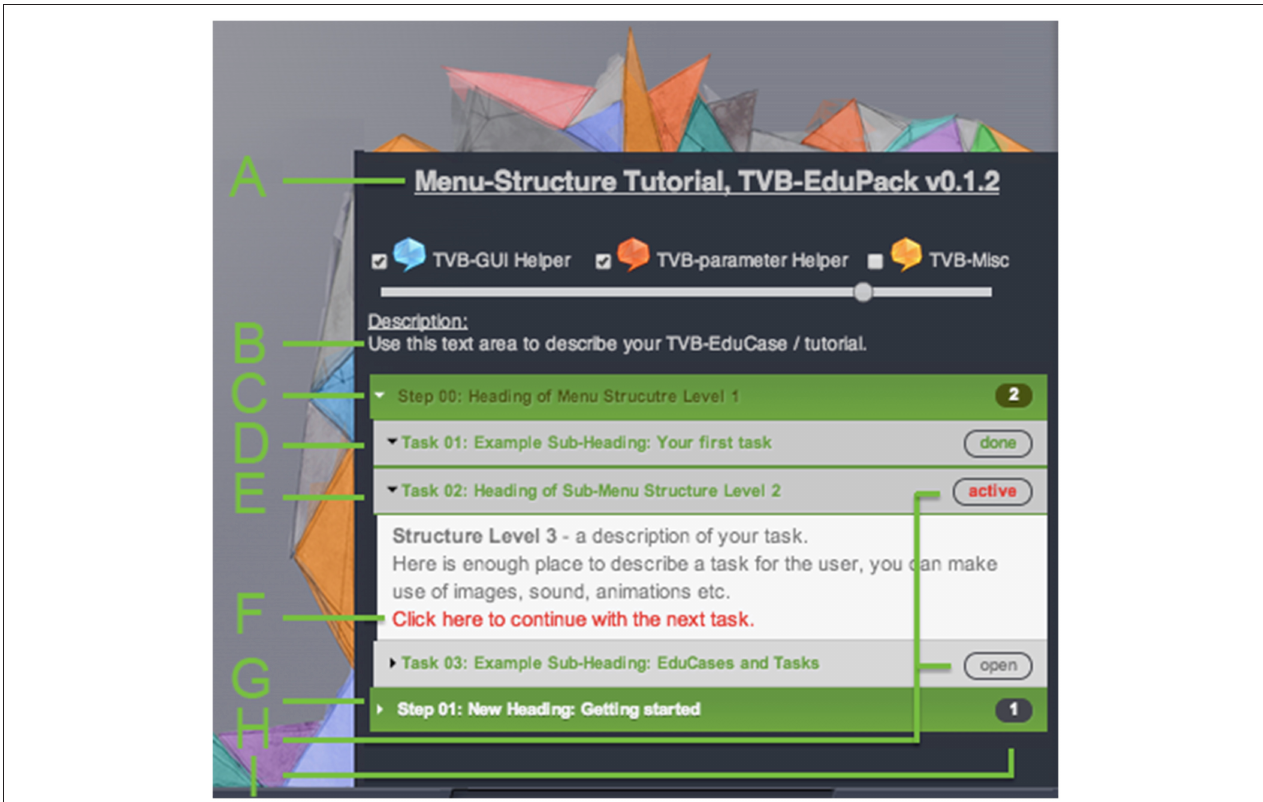
FIGURE 3 | Lower right section of the TVB Connectivity interface with activated TVB-EduPack in Tutorial Mode and with loaded example tutorial (See main text for label